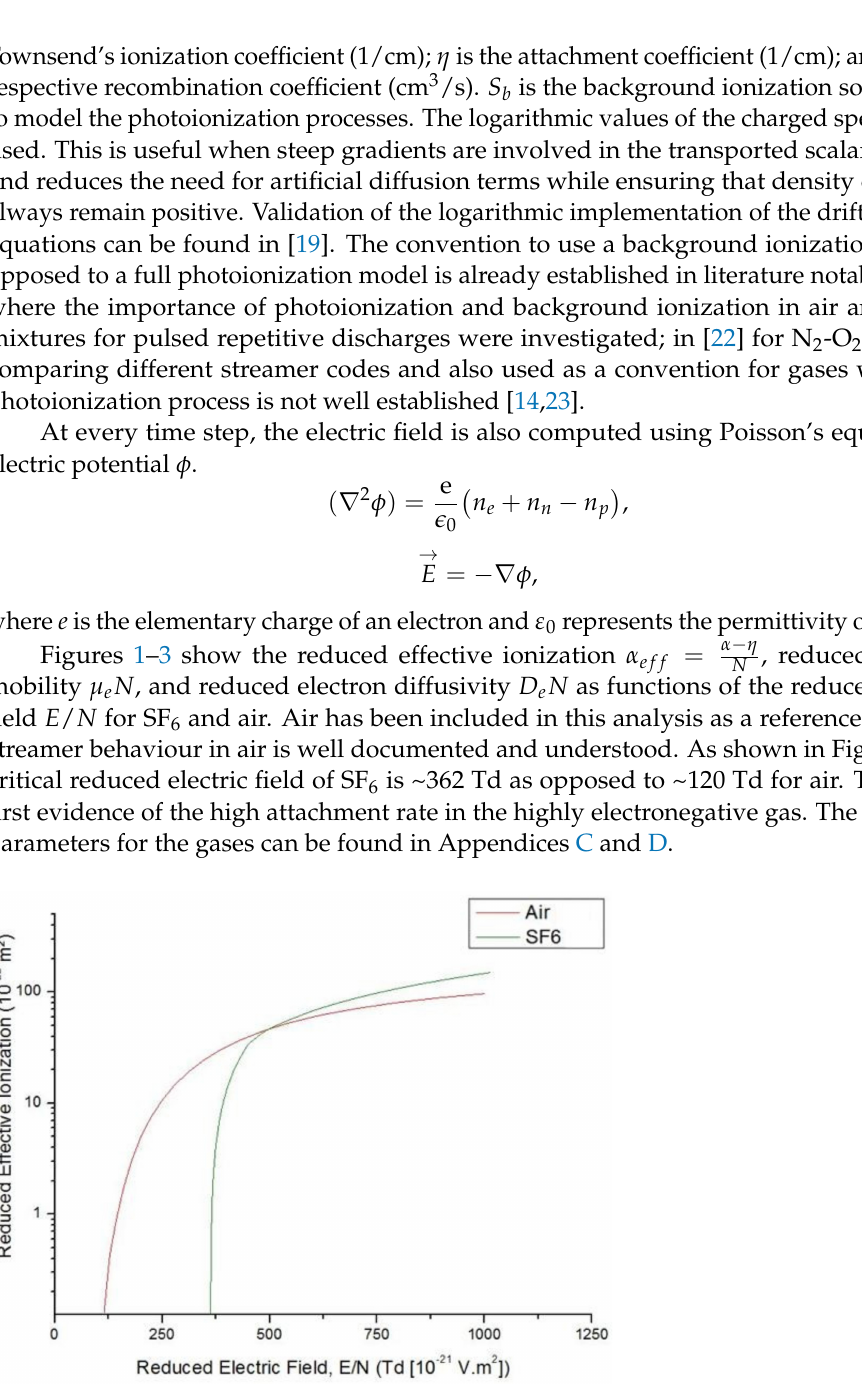
Figure 1. Reduced Effective Ionization as a function of Reduced Electric Field (E/N) for SF 6 [24] and air